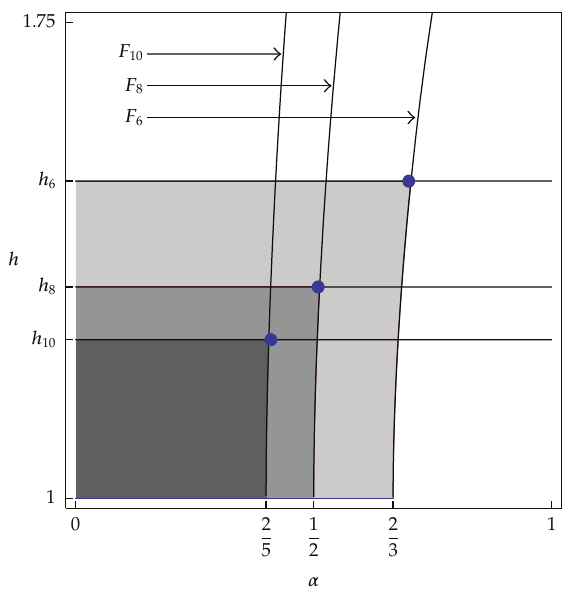
Figure 1: Stability and instability regions for N (cid:7) 6 , 8 ,